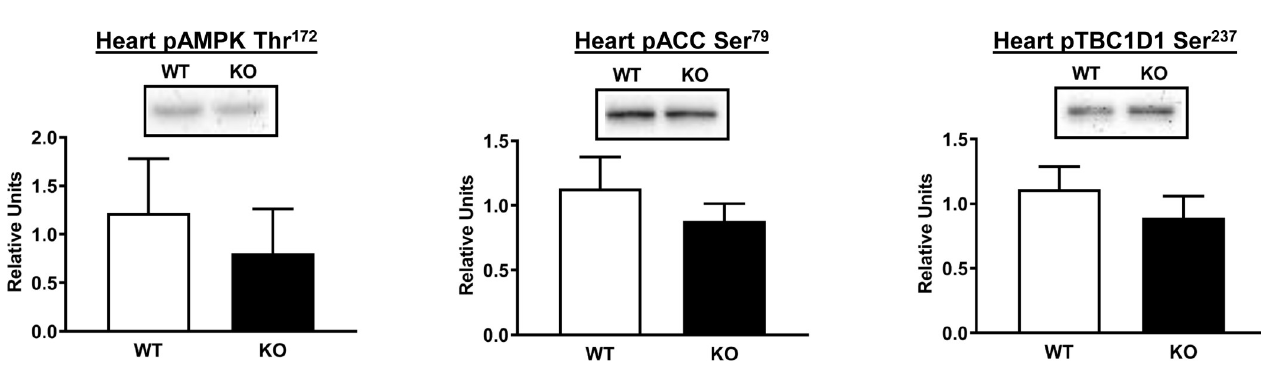
Fig 8. AMPK phosphorylation on Thr 172 (pAMPK Thr172 ), phosphorylation of ACC on Ser 79 (pACC Ser 79 ) and phosphorylation of TBC1D1 Ser 237 in heart from WT (white bars) and KO (black bars) animals subjected to the HEC. Means ± SEM for 4 rats of each genotype.